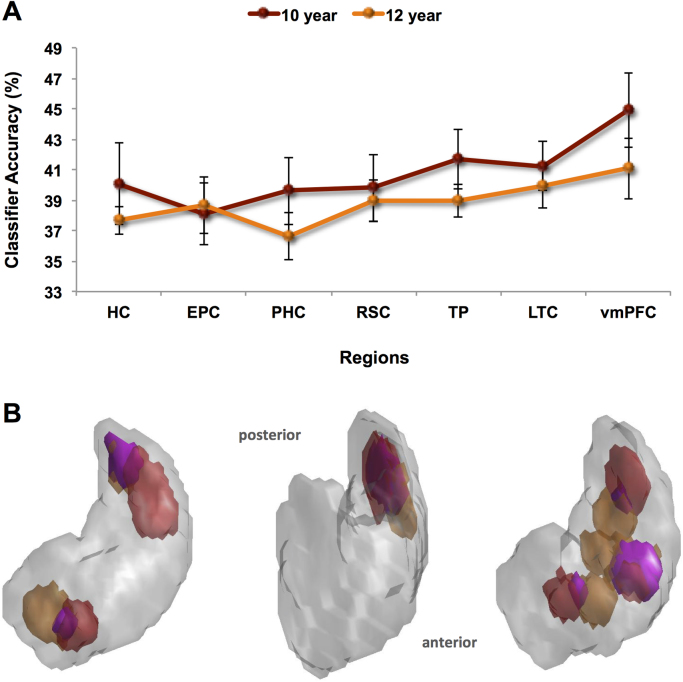
MVPA results for the comparison of the same memories when 10 years old and 12 years old. A. Hippocampus (HC), entorhinal and perirhinal cortices (EPC), parahippocampal cortex (PHC), retrosplenial cortex (RSC), temporal pole (TP), lateral temporal cortex (LTC), and ventromedial prefrontal cortex (vmPFC) were examined. Chance=33%. When memories were ten years old (red line) and then 12 years old (orange line), they were represented in medial temporal regions, including the hippocampus, and this was also the case for the vmPFC. Error bars represent ±1 standard error of the mean. B. Information maps in the hippocampus for the memories when 10 years old (shown in red) and 12 years old (shown in orange) comprised the voxel sets that produced above-chance classification accuracy. The information maps for three example participants are shown superimposed upon 3D images of their right hippocampus. Areas in pink denote where the information maps for the memories at the two different time point overlapped. (For interpretation of the references to color in this figure legend, the reader is referred to the web version of this article.).